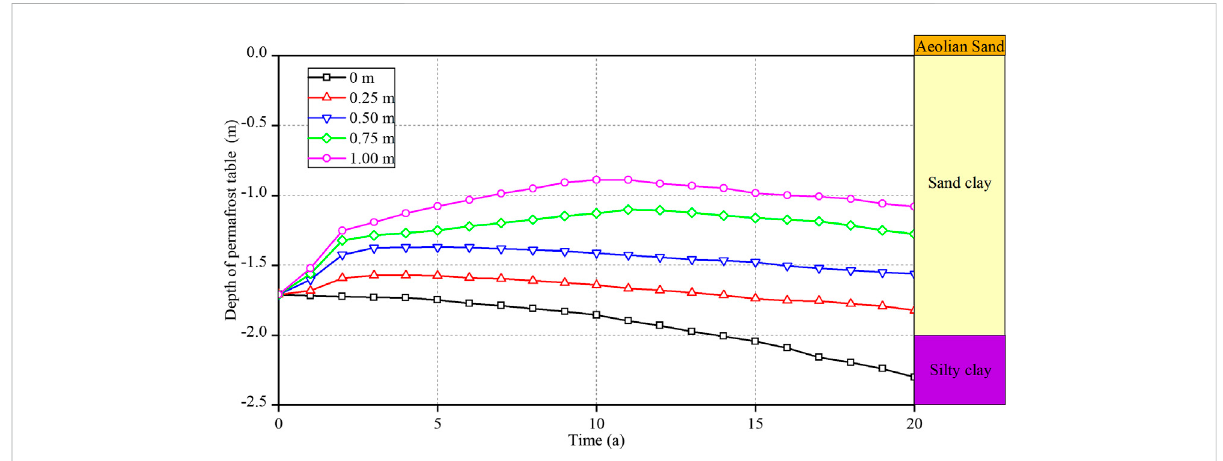
FIGURE 5 Variation of permafrost table of the stratum covered by sand layer with different thickness during 20